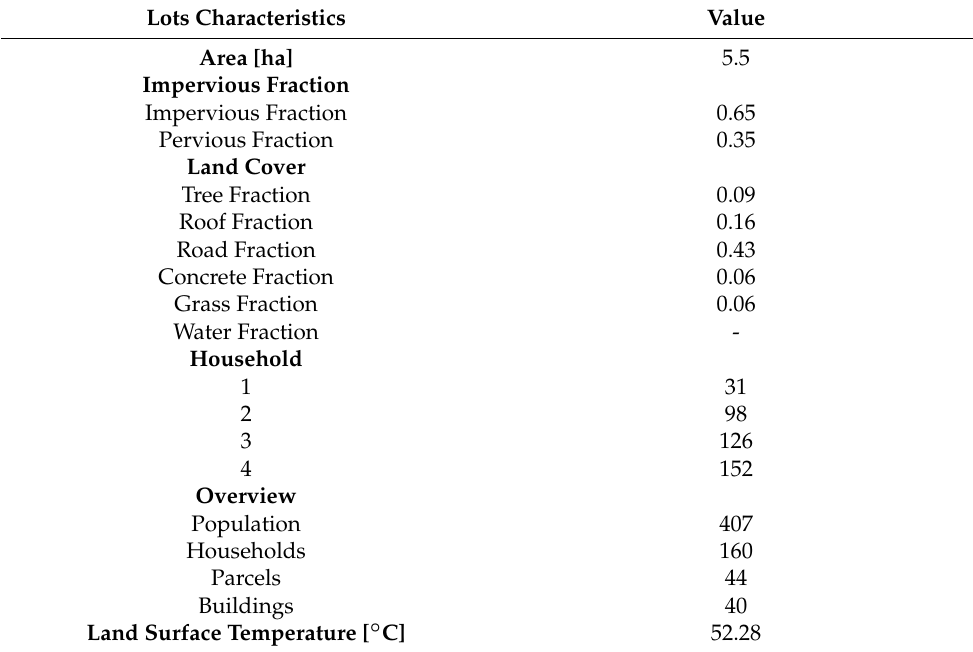
Table 3. Model output data of the new urbanized